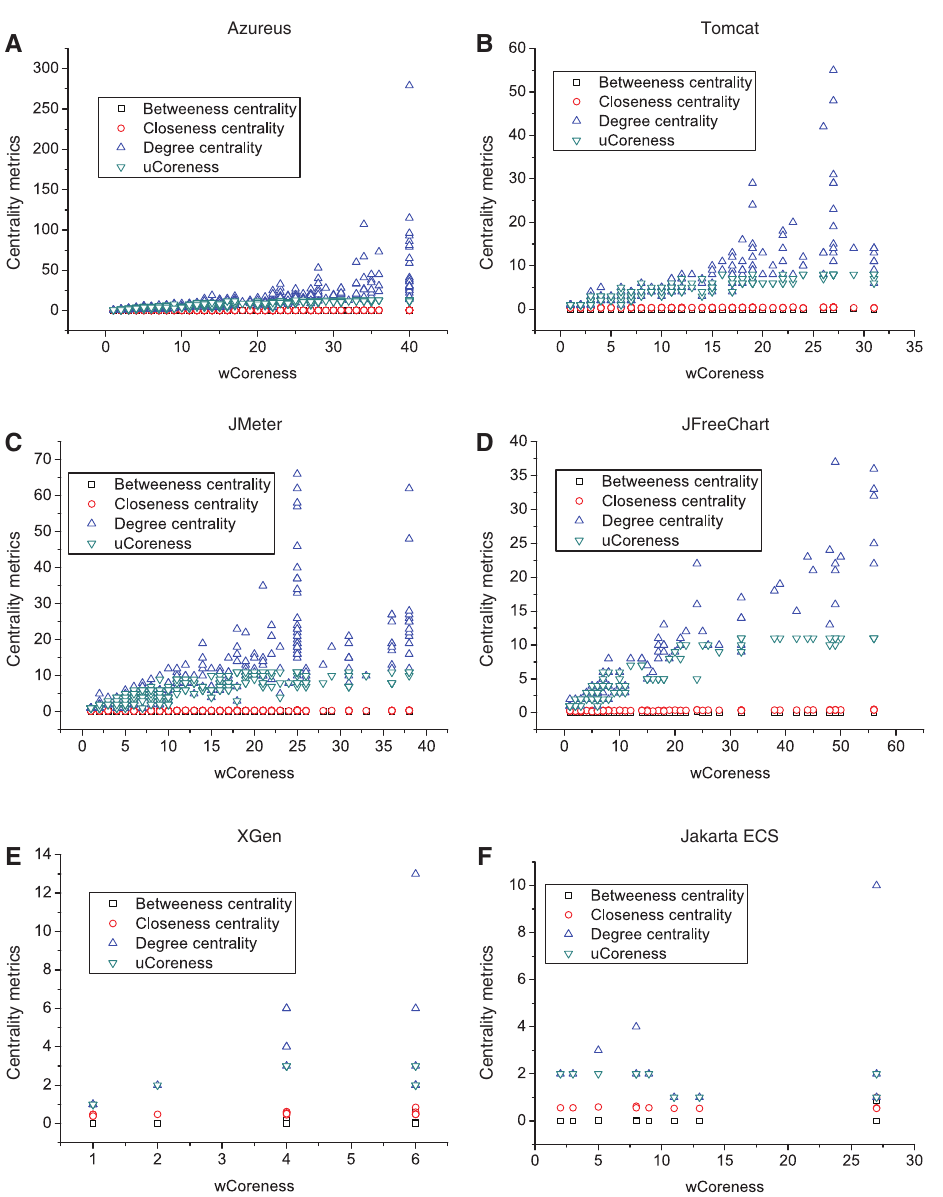
Figure 5. The Relations between wCoreness and Betweenness, Closeness, Degree, and uCoreness Centrality on the Six Networks. Each data point denotes a